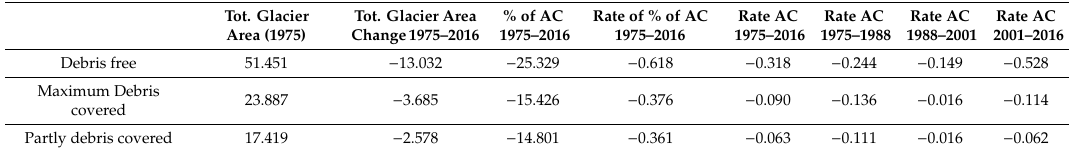
Table 5. Variation in glacier area shrinkage according to glacier types based on debris cover. Tot. Glacier Area (1975)